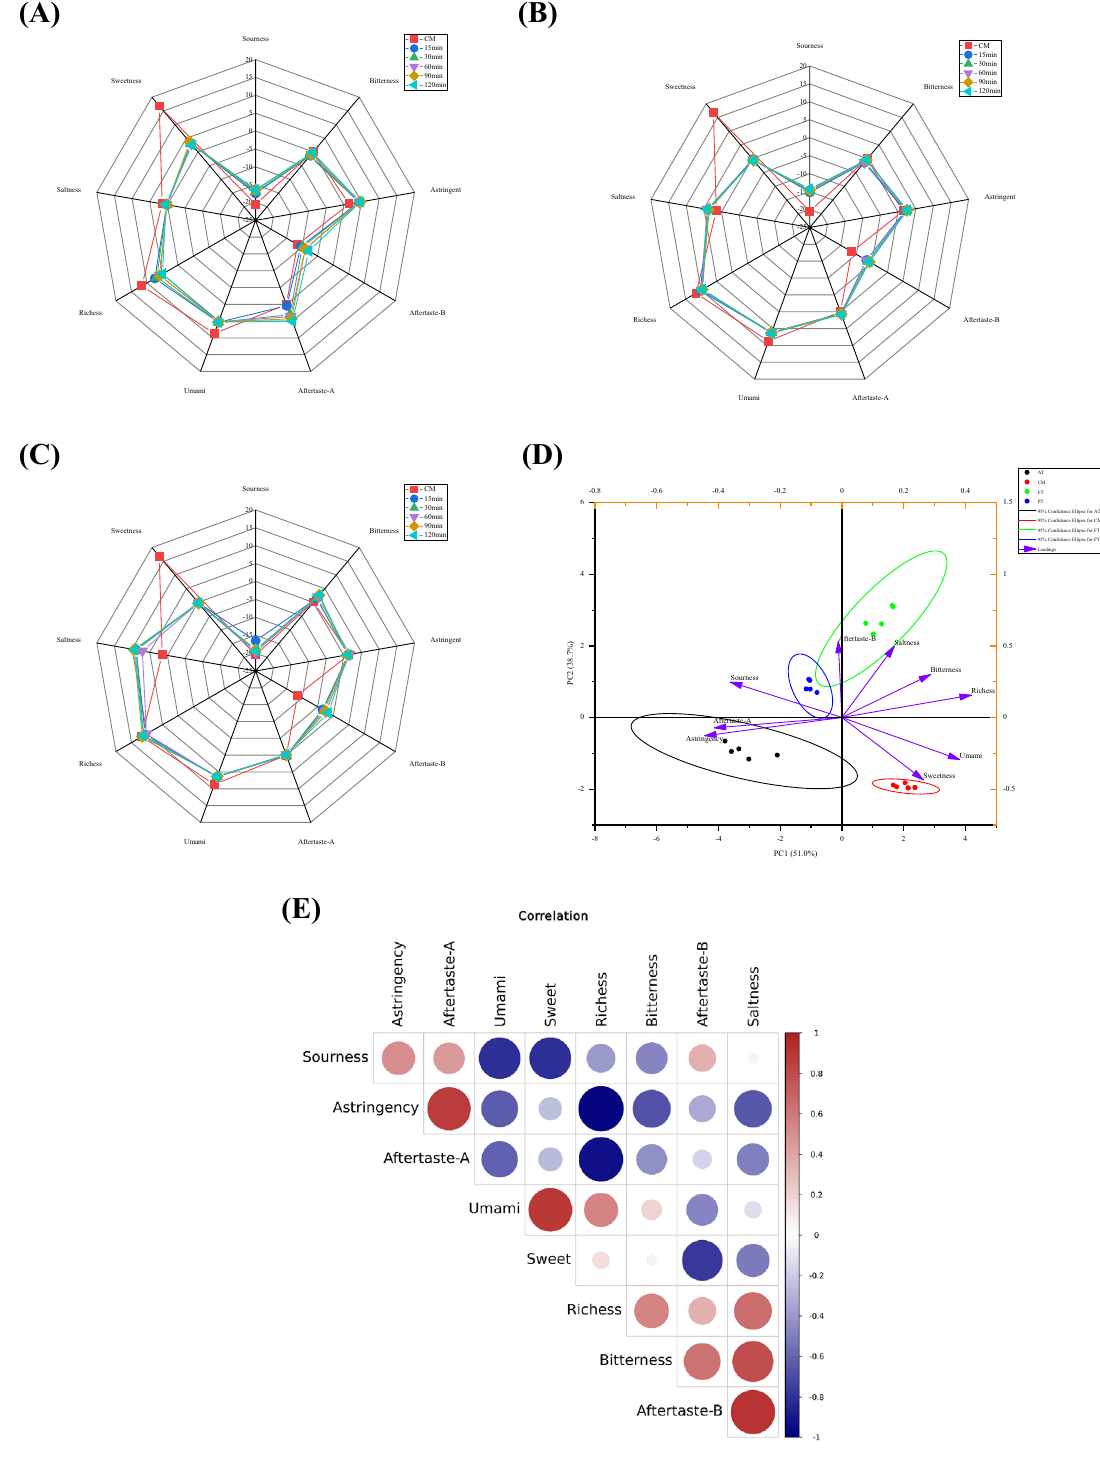
Figure 10. Radar distribution of taste attributes of AT ( A ), PT ( B ), FT ( C ), PCA score plot ( D ) and correlation analysis of sensory ( E ). Alcalase-treated cow milk (AT), Protamex-treated cow milk (PT), Flavourzyme-treated cow milk